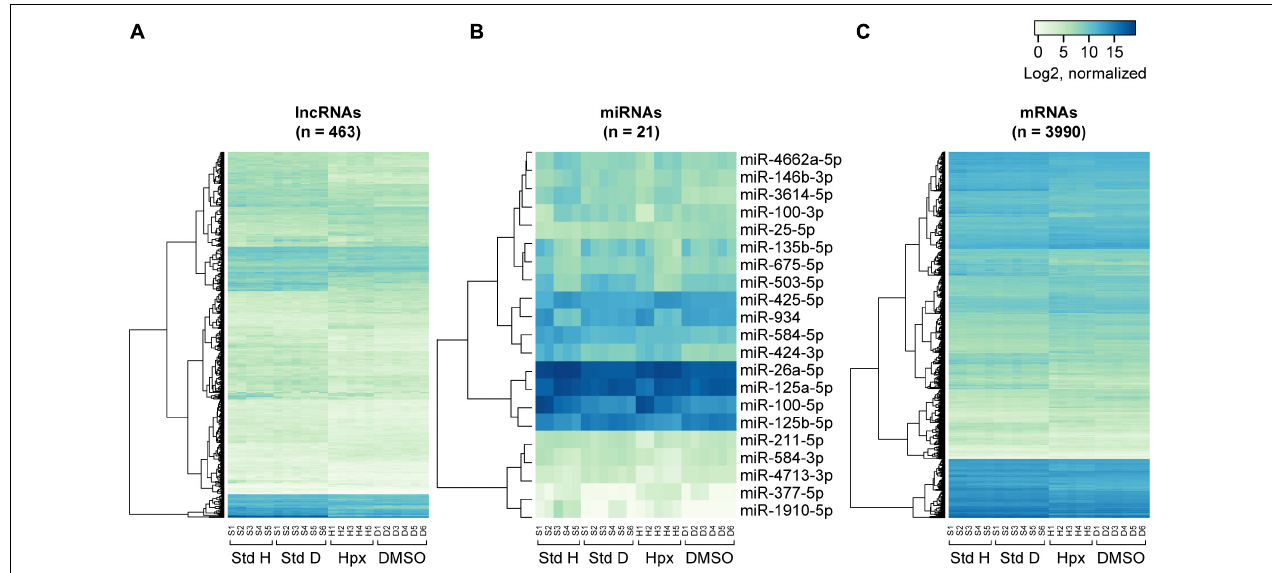
FIGURE 5 | Heatmaps of RNA expression clustering across the experimental paradigms. The heatmaps were constructed on the basis of normalized log2 gene expression for concordantly differentially expressed lncRNAs (A) , miRNAs (B) , and mRNAs (C) in the two exposure sets. Note that the first letter of the sample labels at the bottom of each plot represent experimental condition: “S” for 48 h in standard conditions, “H” for 48 h in hypoxic conditions, and “D” for 48 h in DMSO-containing medium. The number represents placental ID in each experiment. “Std H” and “Std D” refer to 48 h Std conditions in the hypoxia or DMSO experiments,